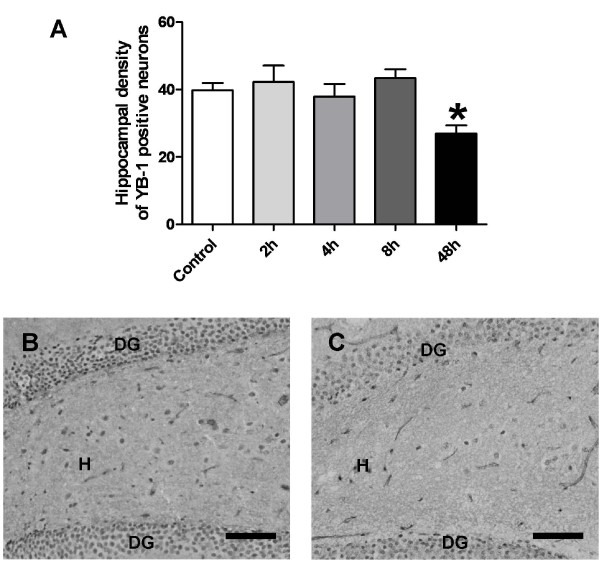
Analysis of neural YB-1 expression in the hippocampal hilus. Data are given as neural density (mean ± SEM). Significant differences to controls are indicated by an asterisk. One way analysis of variance indicated that groups differ significantly (p = 0.0044). (A) Analysis of the hilar density of YB-1 reactive neurons two (n = 2), four (n = 6) or eight hours (n = 7) after status epilepticus did not show significant differences to controls (n = 8) (in all cases p > 0.05). In contrast, the neural density of YB-1 expressing cells was decreased 48 hours (n = 6) after status epilepticus (p = 0.0017). (B) Representative image of the dentate hilus (H) of a control rat. (C) Representative image of the dentate hilus (H) of a rat 48 hours after status epilepticus. Note the tremendous decrease in YB-1 expressing hilar neurons. (DG = dentate gyrus). Scale bar = 100 μm.